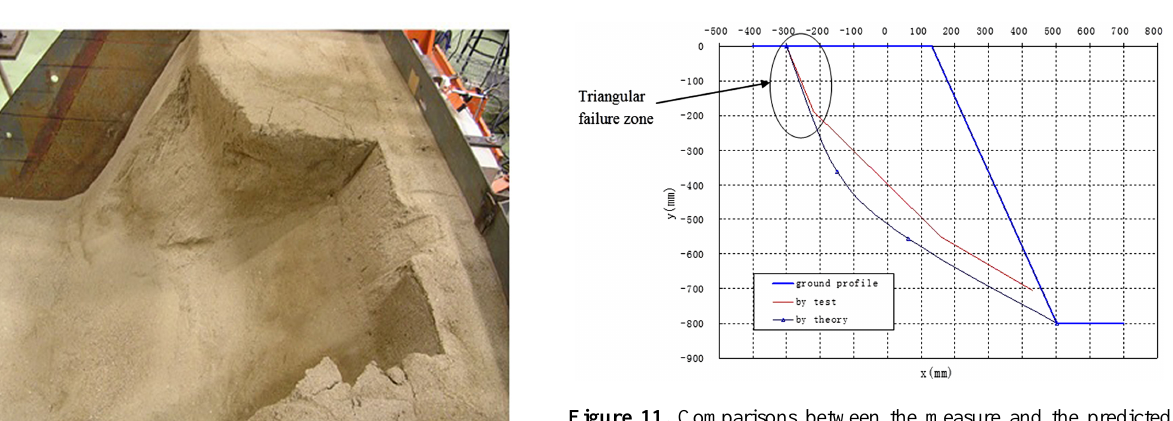
Figure 11. Comparisons between the measure and the predicted failure surface profile at mid-section of